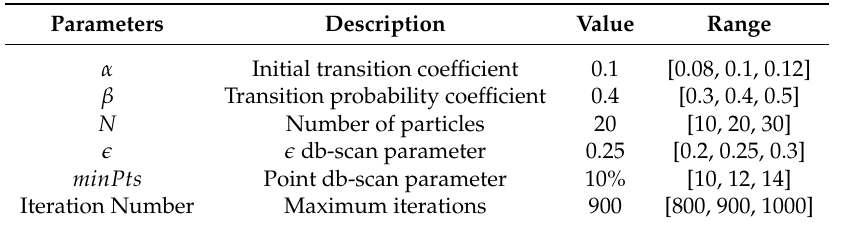
Table 4. Parameter setting for the PSO